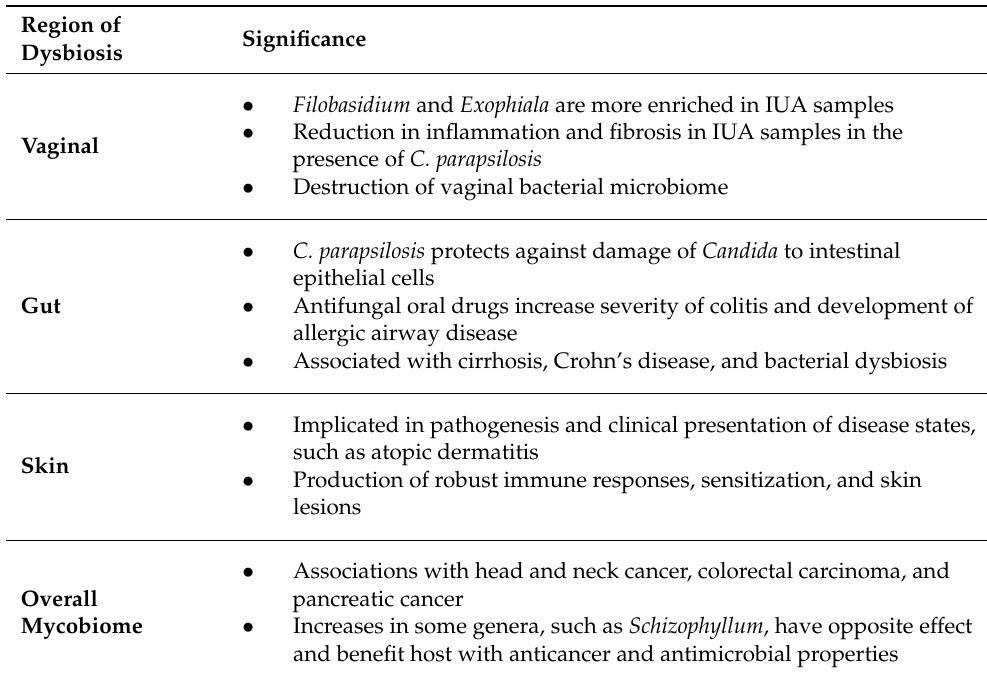
Table 1. Summary of the significance of mycobiome dysbiosis on the human